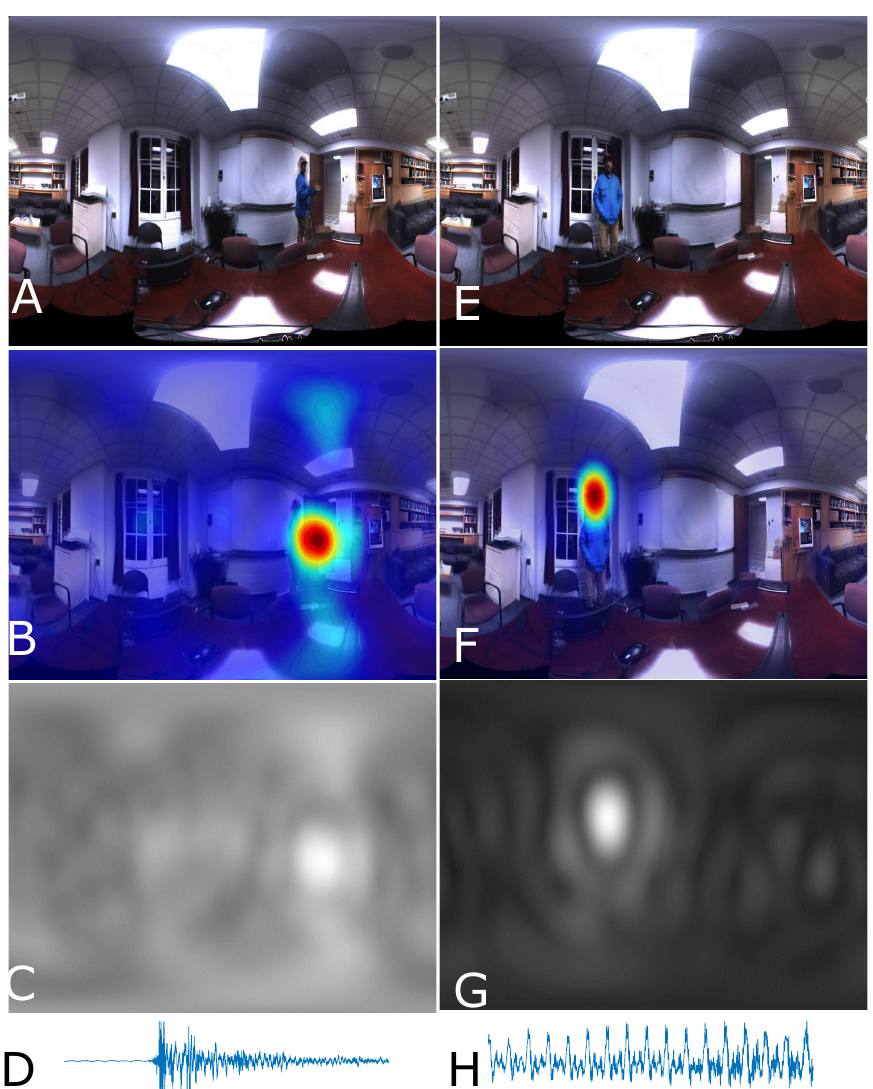
Figure 4. Computation of auditory location and loudness map: two different video frames ( A , E ); the corresponding audio samples from one of the audio channels , which display only 4410 samples, i.e., audio of 0.1 s ( D , H ); the corresponding auditory loudness and location maps ( C , G ); and the corresponding video overlays, which are for illustration only, not used in any computation ( B , F ). ( Left ) Sound of a clap; and ( Right ) some part of the word “eight” uttered by the